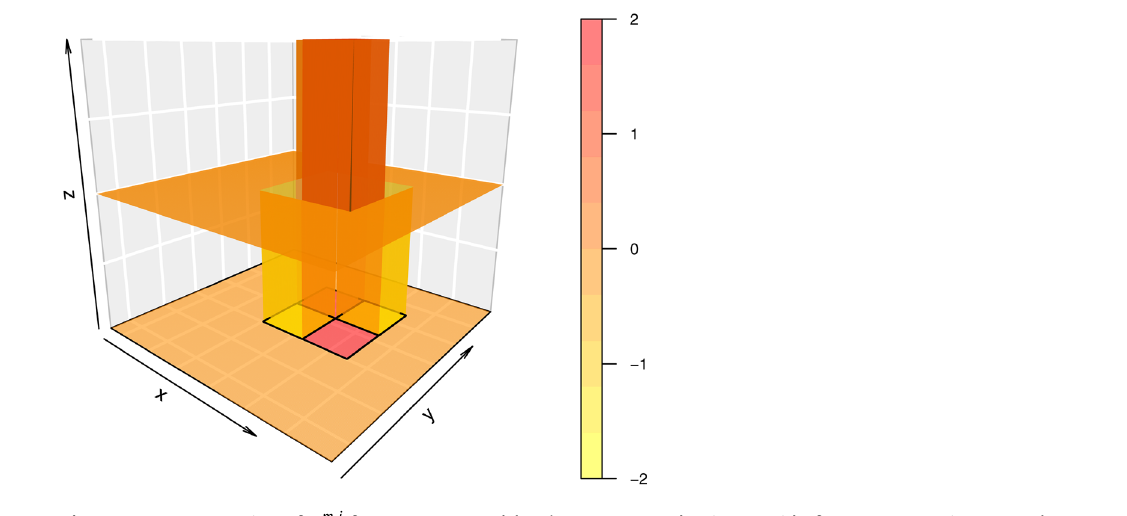
Figure 5: Representation of H 4 1 4  × − , − , 1 2 5 2 5